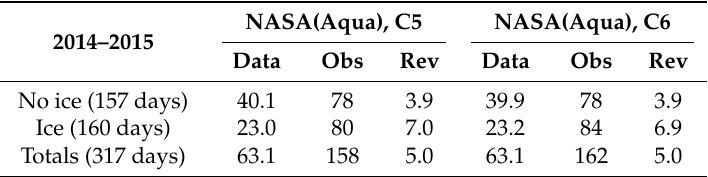
Table 6. Comparison of NASA(Aqua) C5 to C6 reprocessing, on river grids cells only. Data: see Equation (2); Obs: number of days on which at least one grid cell was observed; Rev: see Equation (1), in